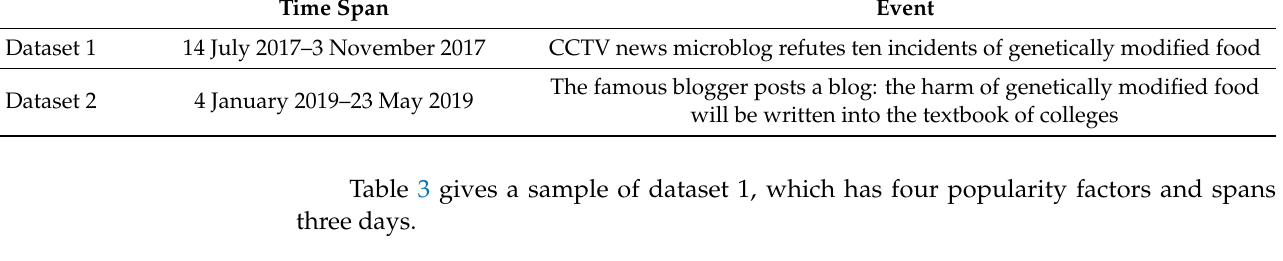
Table 3. The details of sample data in dataset